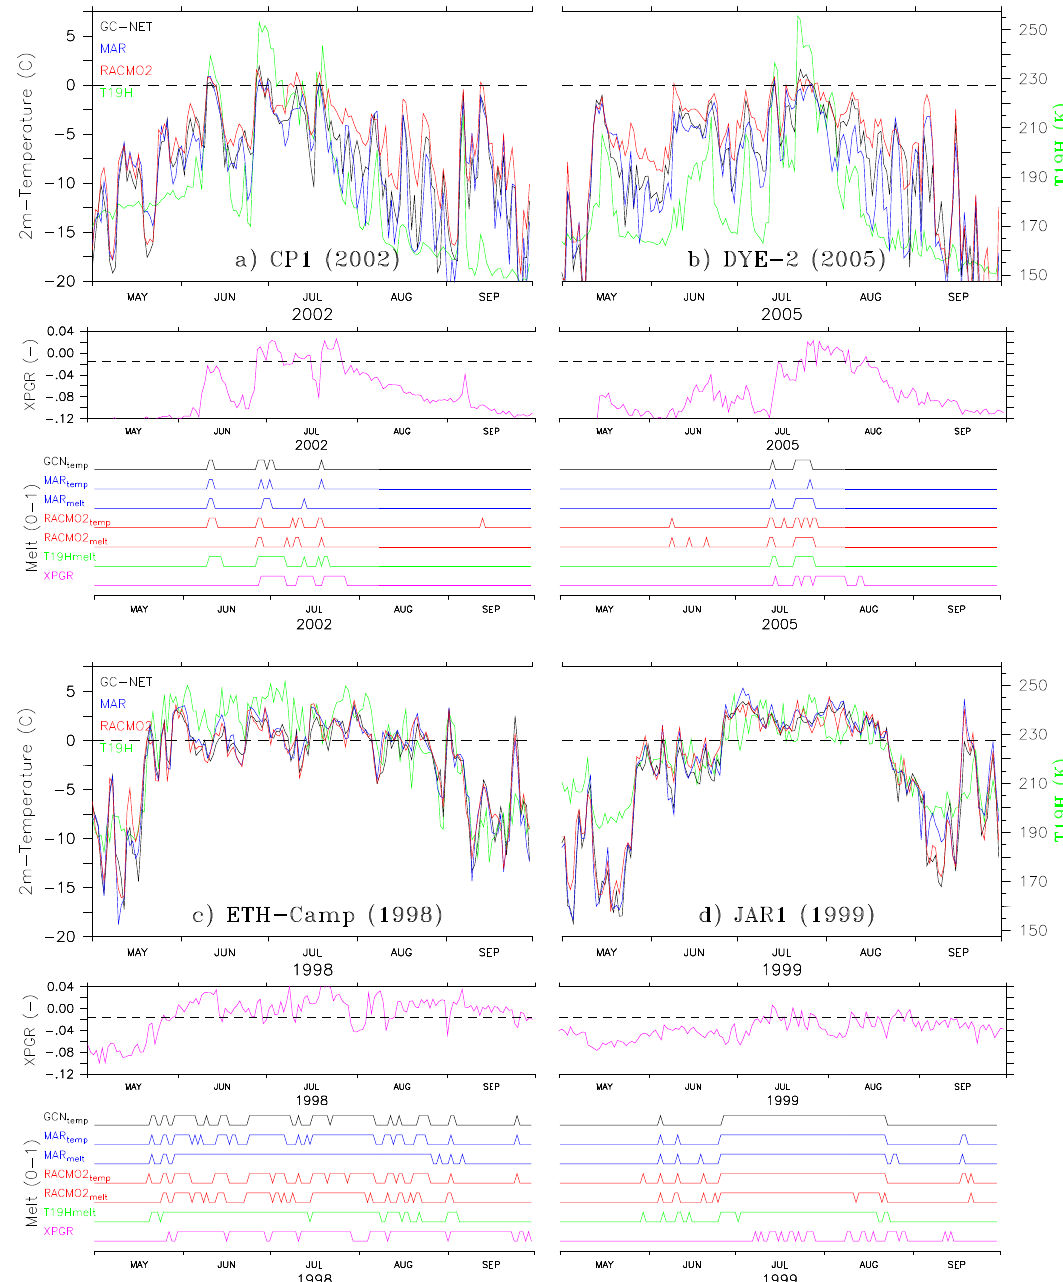
Fig. 1. (a) Top – Daily mean near-surface temperature (in black) observed in summer 2002 at Crawford Point 1 (69.9 ◦ N, 47 ◦ W, 2022m), 3m-temperature simulated by the MAR model (in blue), 2m-temperature simulated by the RACMO2 model (in red) and, the T19H brightness temperature (in green on the left axe) for the pixel nearest CP1. Middle – the XPGR value as defined by Abdalati and Steffen (2001). The dotted line shows the XPGR threshold value used by Abdalati and Steffen (2001) for melt detection. Below – the Melt/no melt time series derived from observation (daily mean temperature ≥ 0 ◦ C), simulated by the RCMs (see Table 2), derived from the T19H temperature by using Eq. 1 and using the XPGR algorithm. (b) The same as (a) but for DYE-2 (66.5 ◦ N, 46.3 ◦ W, 2165m) in 2005. (c) The same as (a) but for ETH-Camp (69.6 ◦ N, 49.2 ◦ W, 1149m) in 1998. (d) The same as (a) but for JAR-1 (69.5 ◦ N, 49.6 ◦ W, 962m) in 1999.